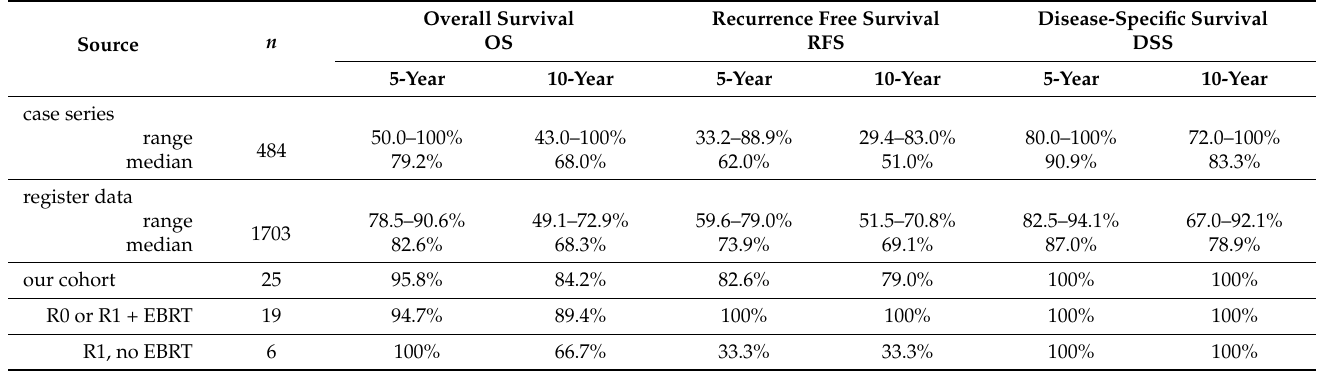
Table 7. Survival across Parathyroid Cancer